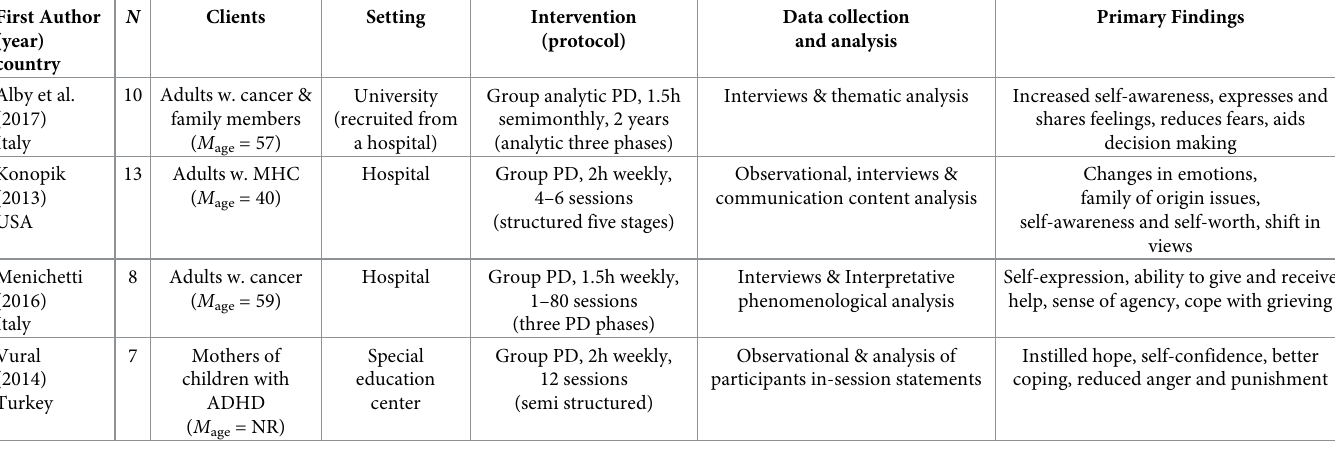
Table 1. Characteristics of the qualitative